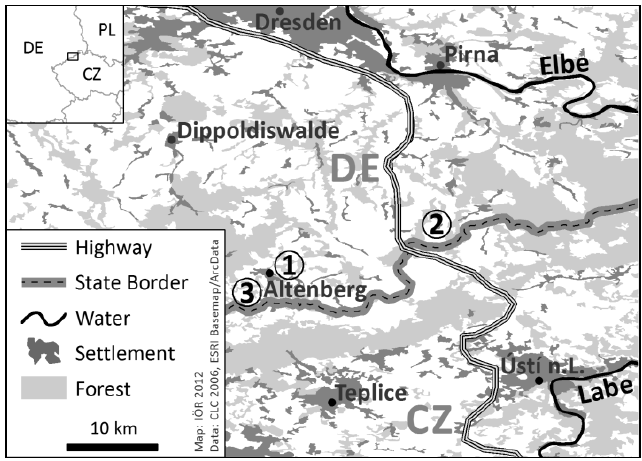
Figure 1: The Eastern Ore Mountains with the study sites Geisingberg meadows (1), Oelsen meadows (2) and